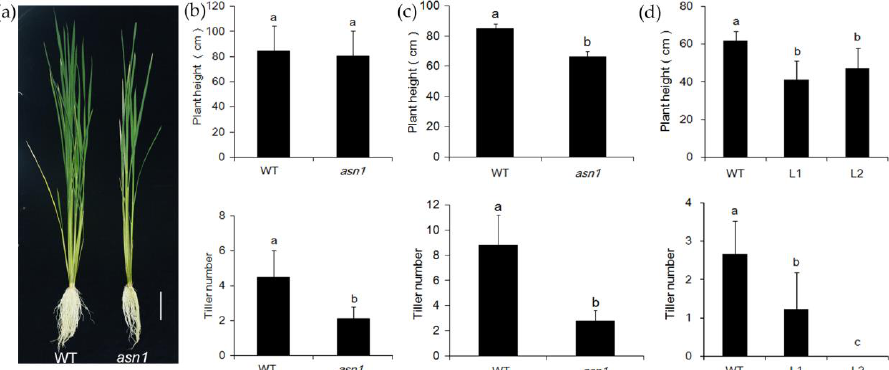
Figure 5. Phenotypic analysis of WT and asn1 at the later stage. ( a ) WT and asn1 treated with 2.5 mM NH 4+ for 60 days; ( b ) plant height and tiller number of plants in ( a ); ( c )plant height and tiller number of plants in paddy field at heading stage; ( d ) plant height and tiller number of WT and L1, L2. The scale bar is 10 cm. Data are mean ± SD ( n ≥ 8). Means with different letters are significantly different.